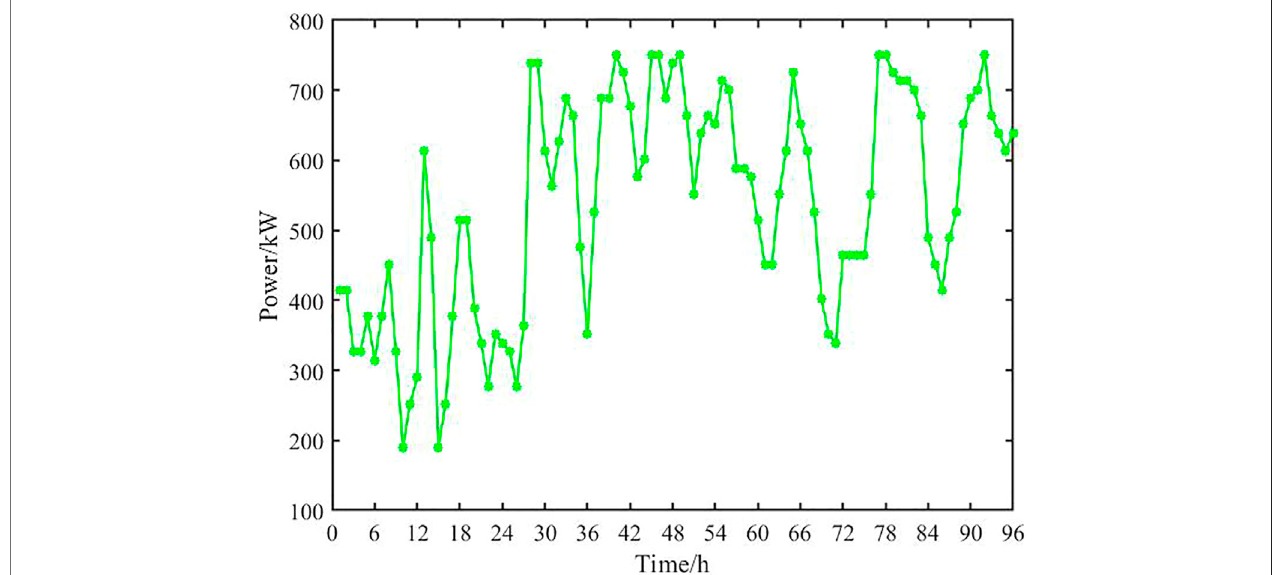
FIGURE 3 | Forecast values of the output of single wind turbine during typical days of four seasons.